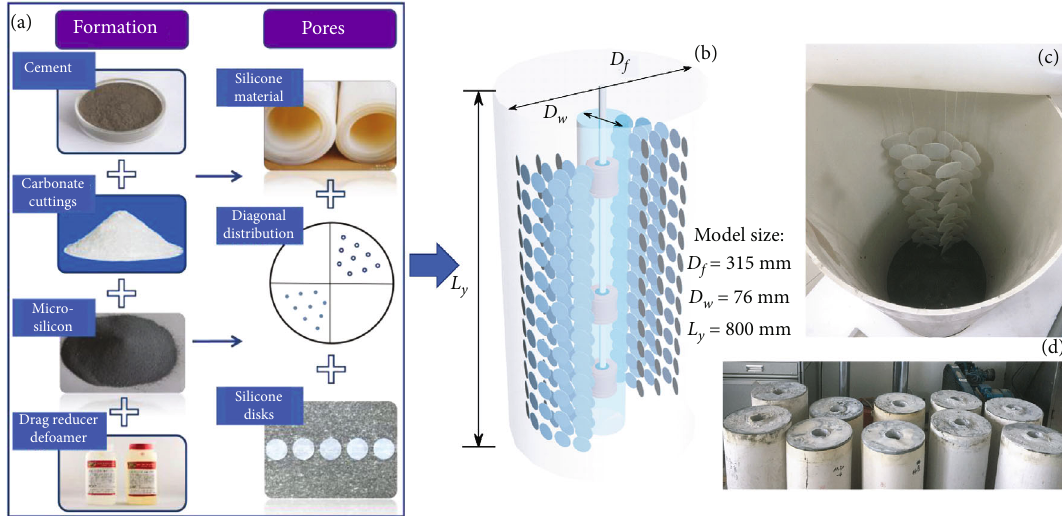
Figure 2: (a) The material and building process of the borehole model. (b) A schematic physical model with the homemade acoustic logging system. (c) The distribution of the silicone disks. (d) The borehole models after coring in the center.